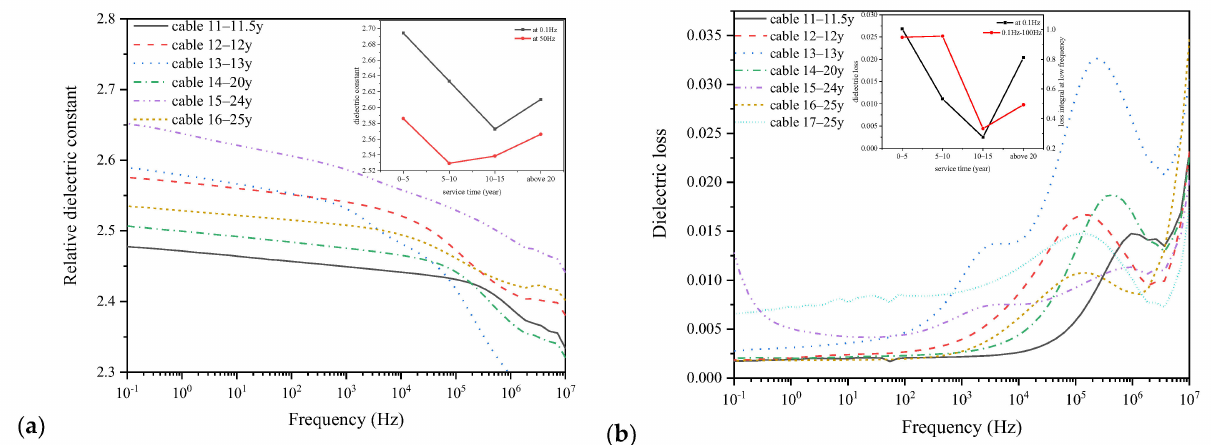
Figure 8. Dielectric properties of XLPE films of cables with different service years. ( a ) Relative dielectric constant; ( b ) dielectric loss.